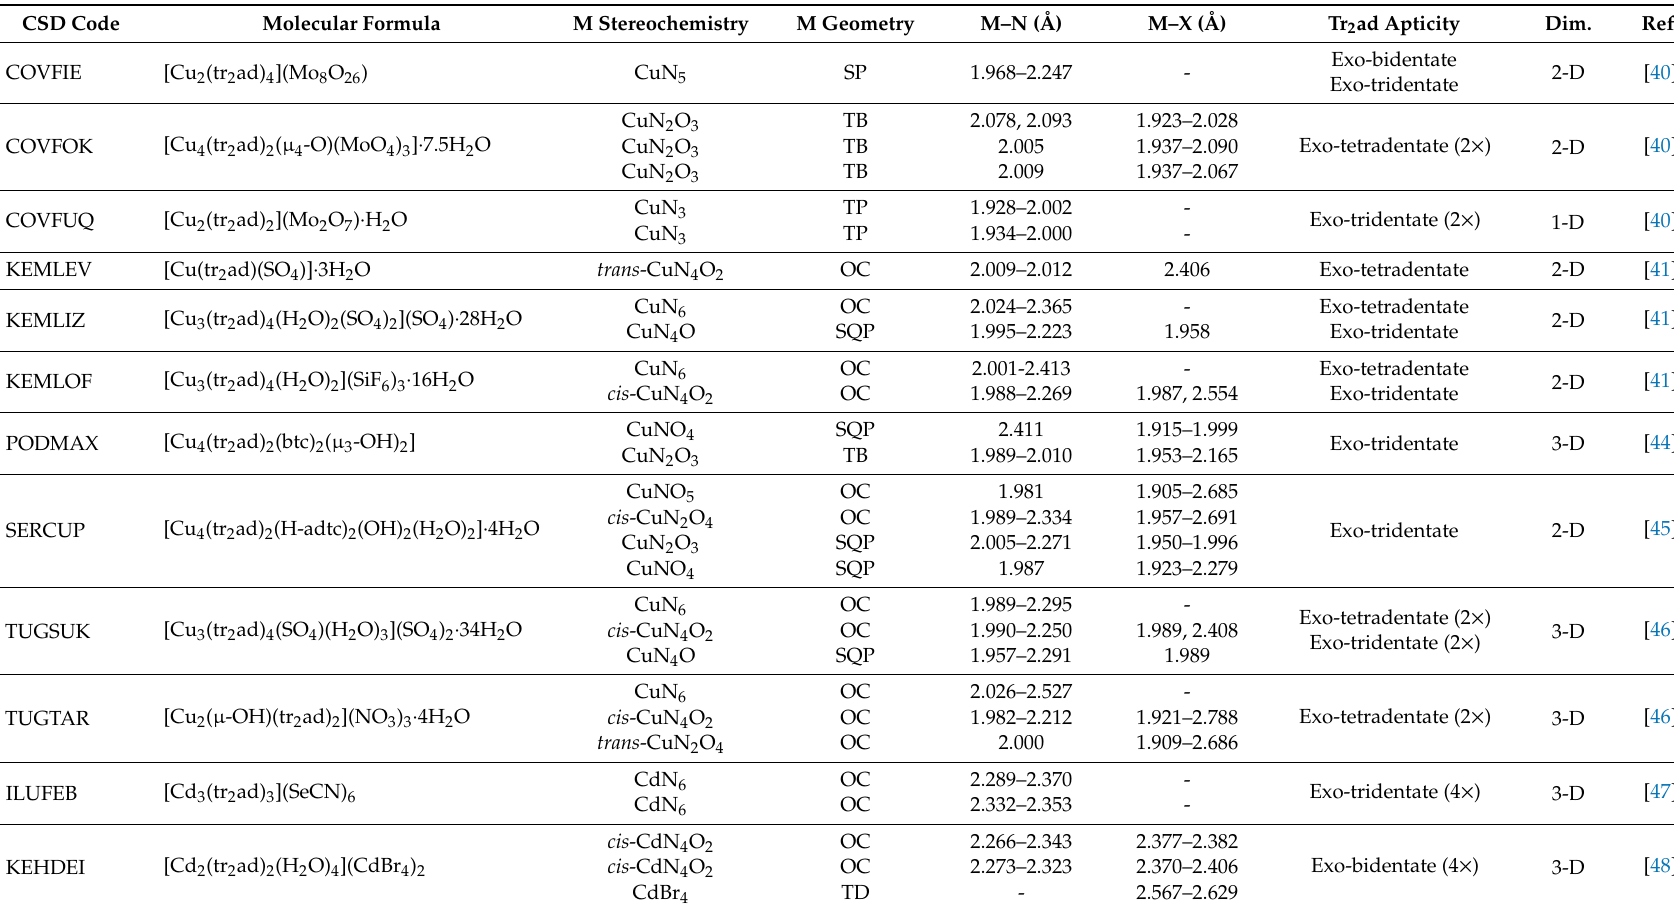
Table 1. Main structural properties of the known coordination polymers containing the tr 2 ad ligand. Abbreviations: M = metal ion; OC = octahedral; SP = square planar; SQP = square pyramidal; TB = trigonal bipyramidal; TD = tetrahedral; TP = trigonal planar; H 3 btc = 1,3,5-benzenetricarboxylic